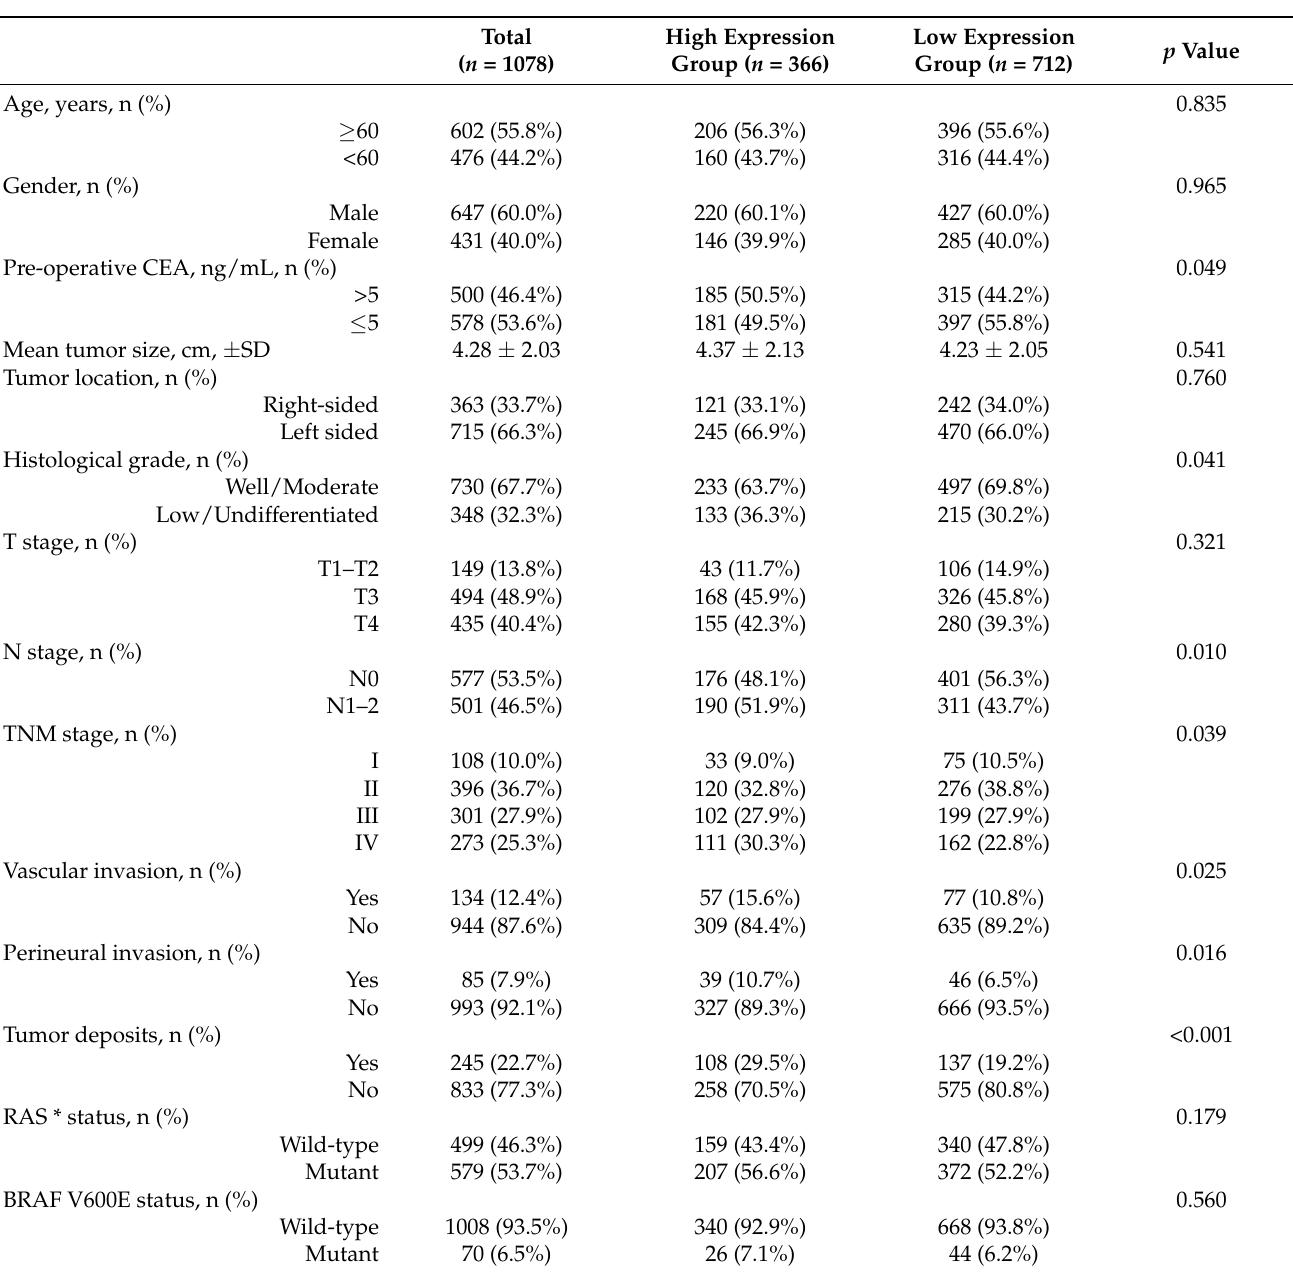
Table 1. Correlation between baseline characteristics and CUL9 expression in the primary